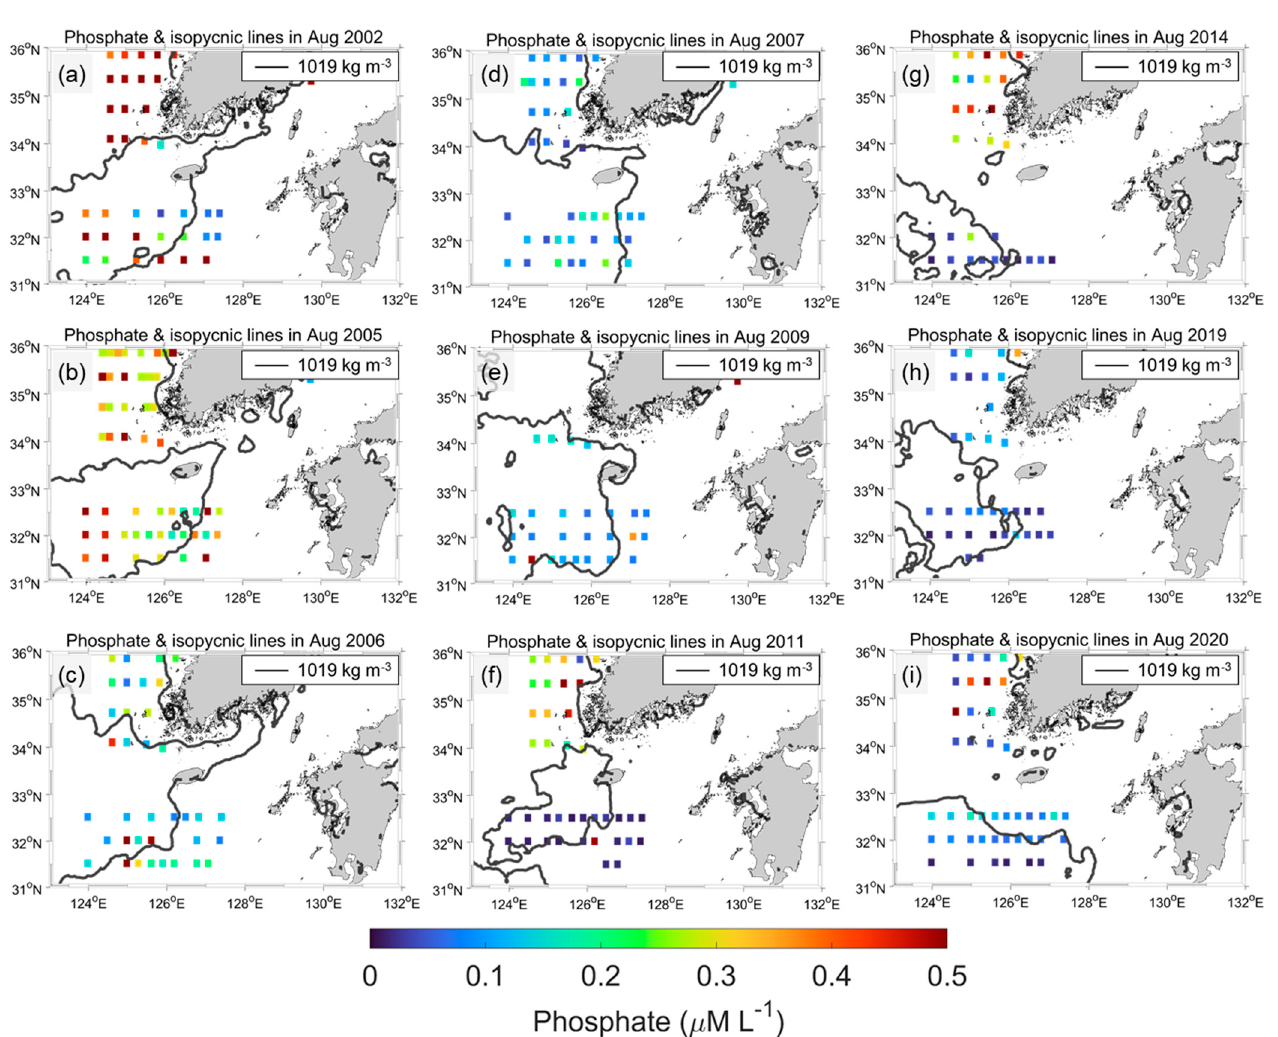
Figure 10. ( a − i ) Same as Figure 9 but phosphate during August 2002, 2005, 2006, 2007, 2009, 2011, 2014, 2019, and